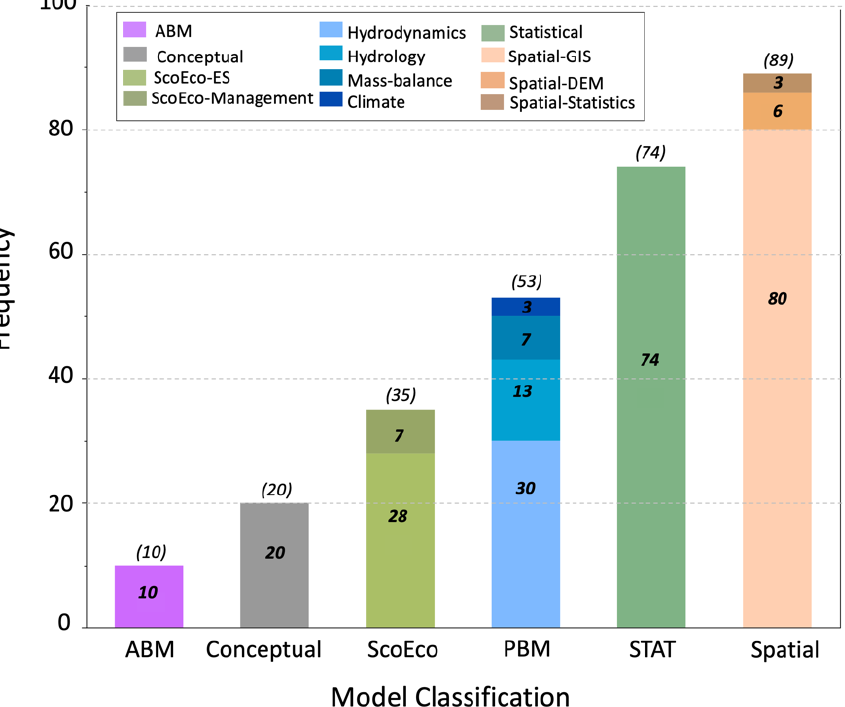
Figure 1. Total number of publications for different types of models identified in the analysis up to 2021. ABM: agent-based model; conceptual model; ScoEco: socioeconomic/management model; PBM: process-based model; STAT: statistical model; spatial based model. See model type/subtype description in the Section 2.2 and in Table 1. The number in parentheses on top of the bars is the total number of publications for each model category.